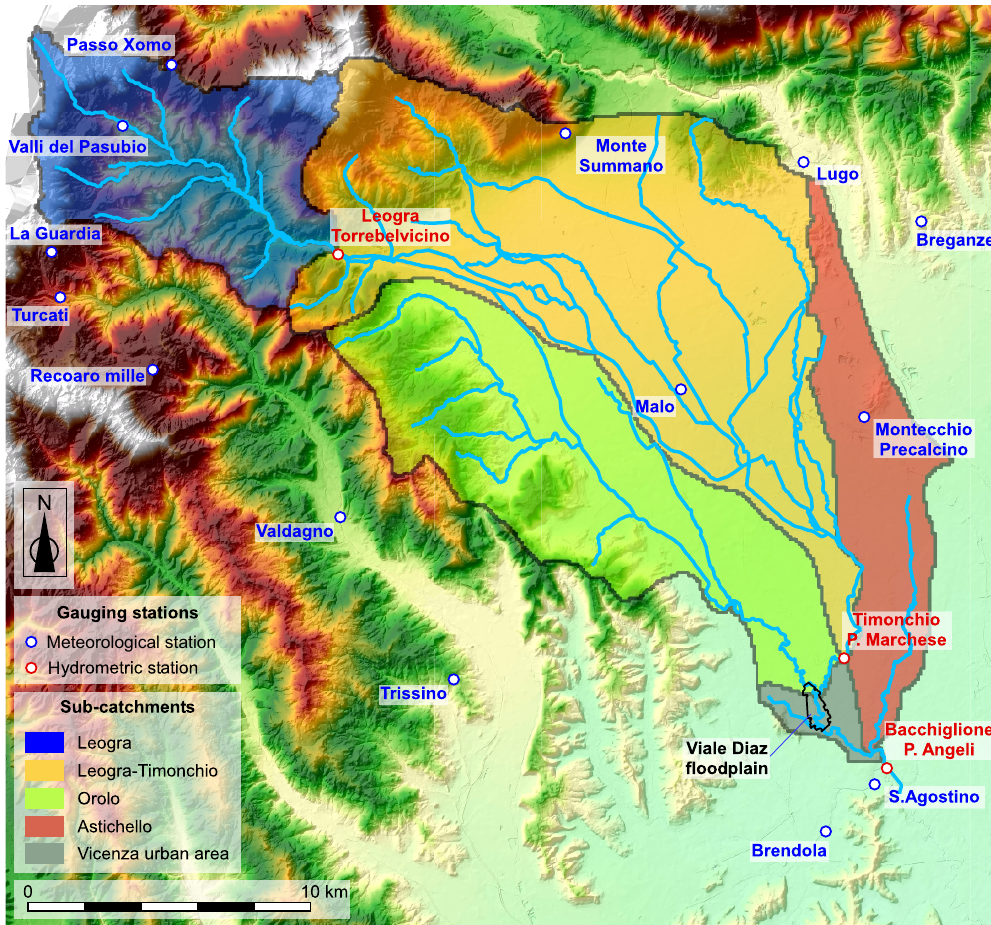
Figure 1. The catchment of the Bacchiglione River at Ponte degli Angeli, Vicenza